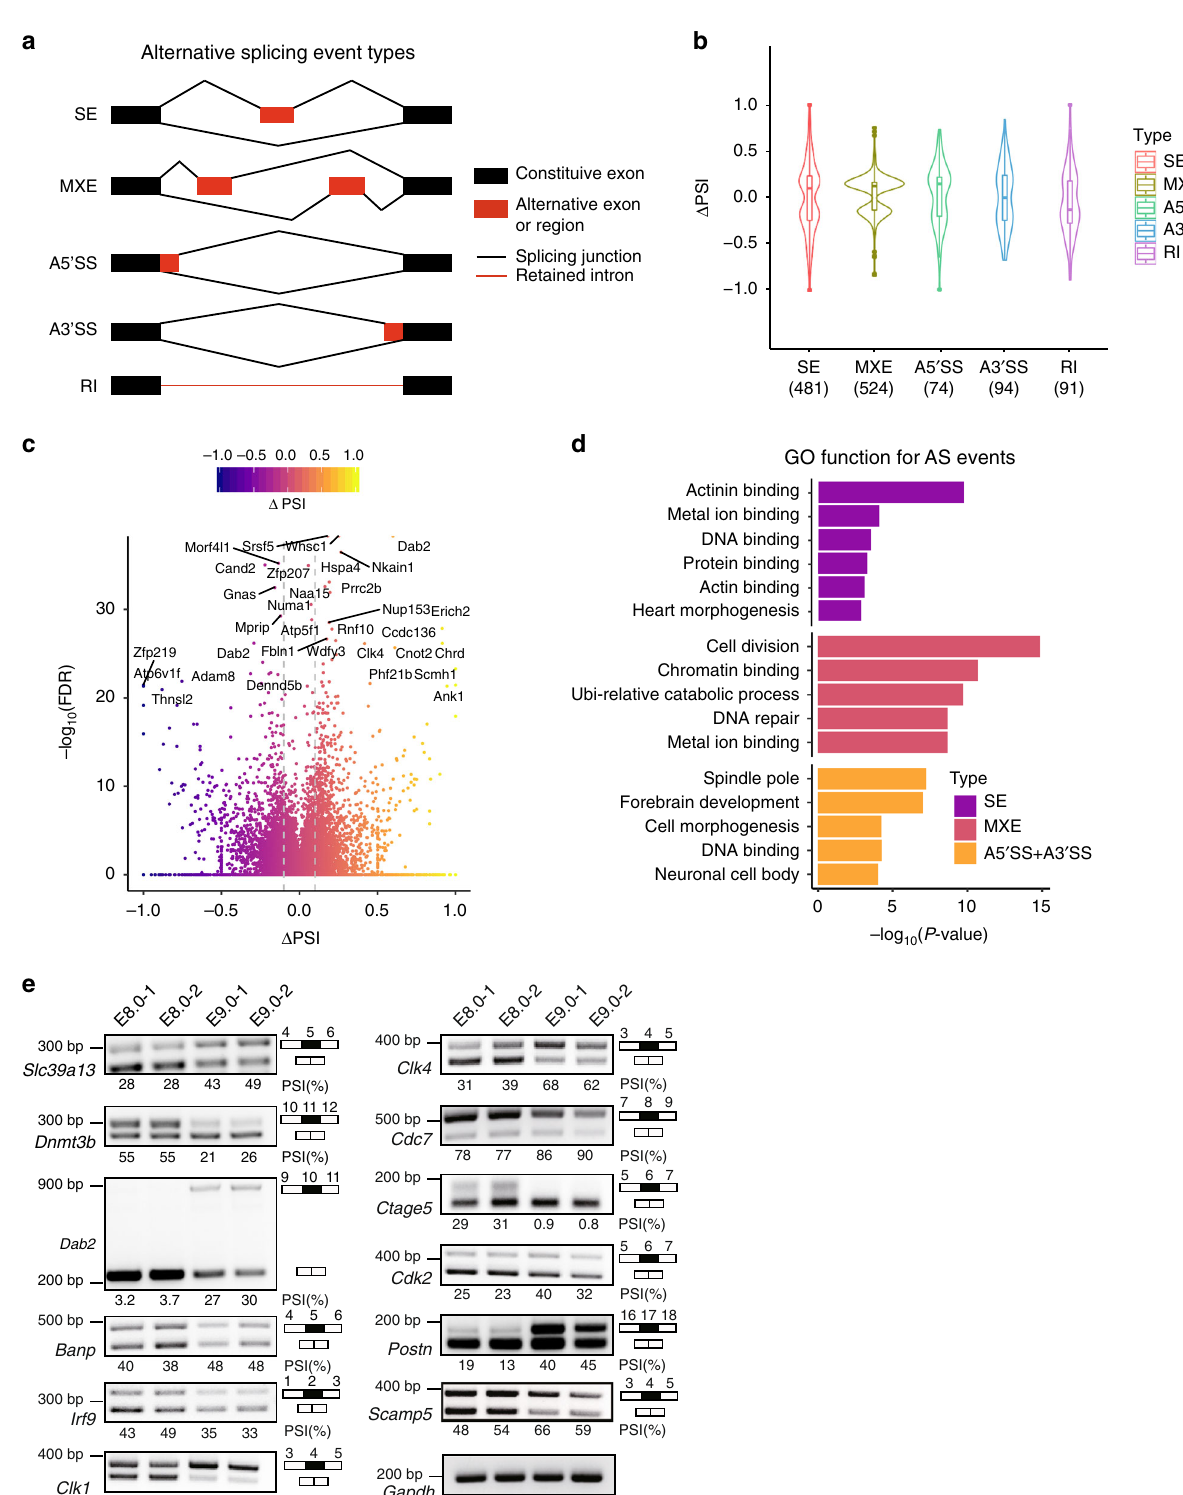
MS/MS (Supplementary Fig. 3b and Supplementary Data 3). Mul- tiple sub-complexes of the spliceosome were identi fi ed, including components of the major snRNPs (U1, U2, U4/U6, and U5) and some splicing factors (Fig. 3a). The ranked scores assigned by the COMPLEAT tool 29 showed that 29.6% of hits (45 of 152) partici- pated in various predicted networks between splicing protein interactions (Fig. 3b and Supplementary Fig.